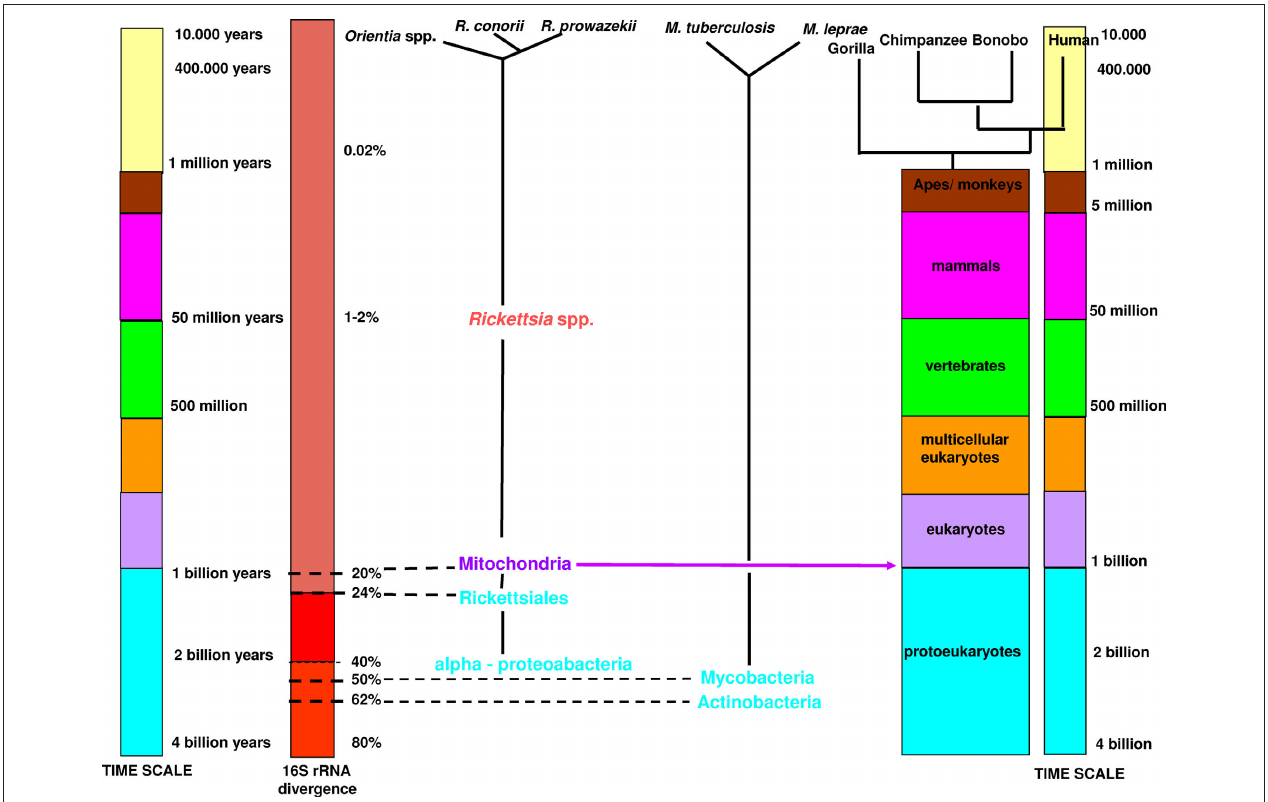
Figure 3 | Time-scale comparison between animal and bacterial